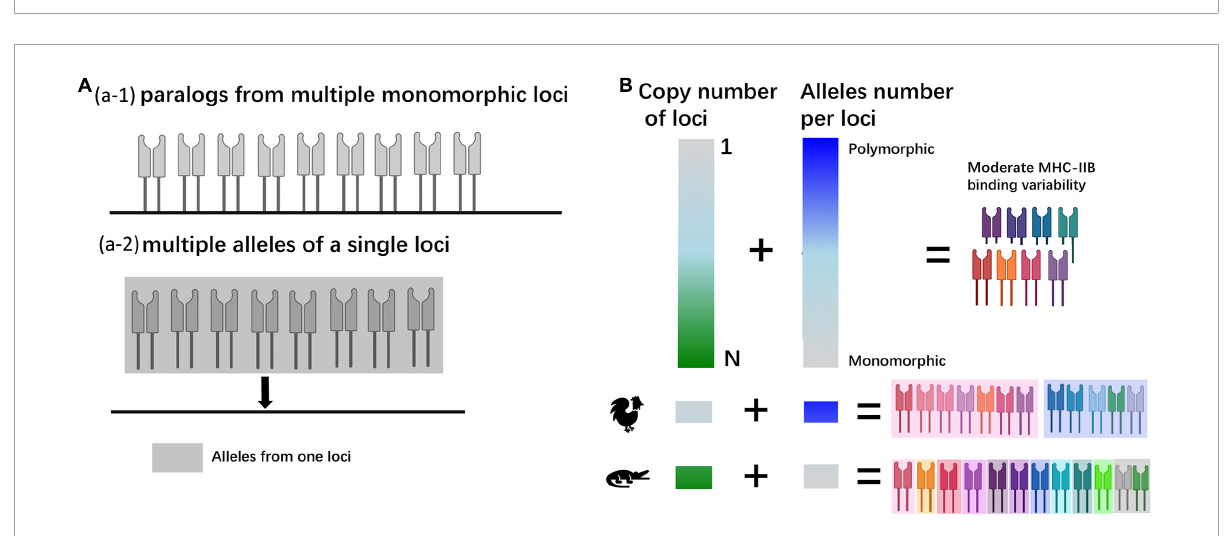
FIGURE8 (A) The mechanism of polymorphism in antigen-presenting proteins. (a-1) An extreme model with paralogs from multiple loci, and each locus is monomorphic. (a-2) An extreme model with all the alleles from one locus. (B) The causes of gene polymorphism in two aspects and the speculated models for chicken and the Chinese